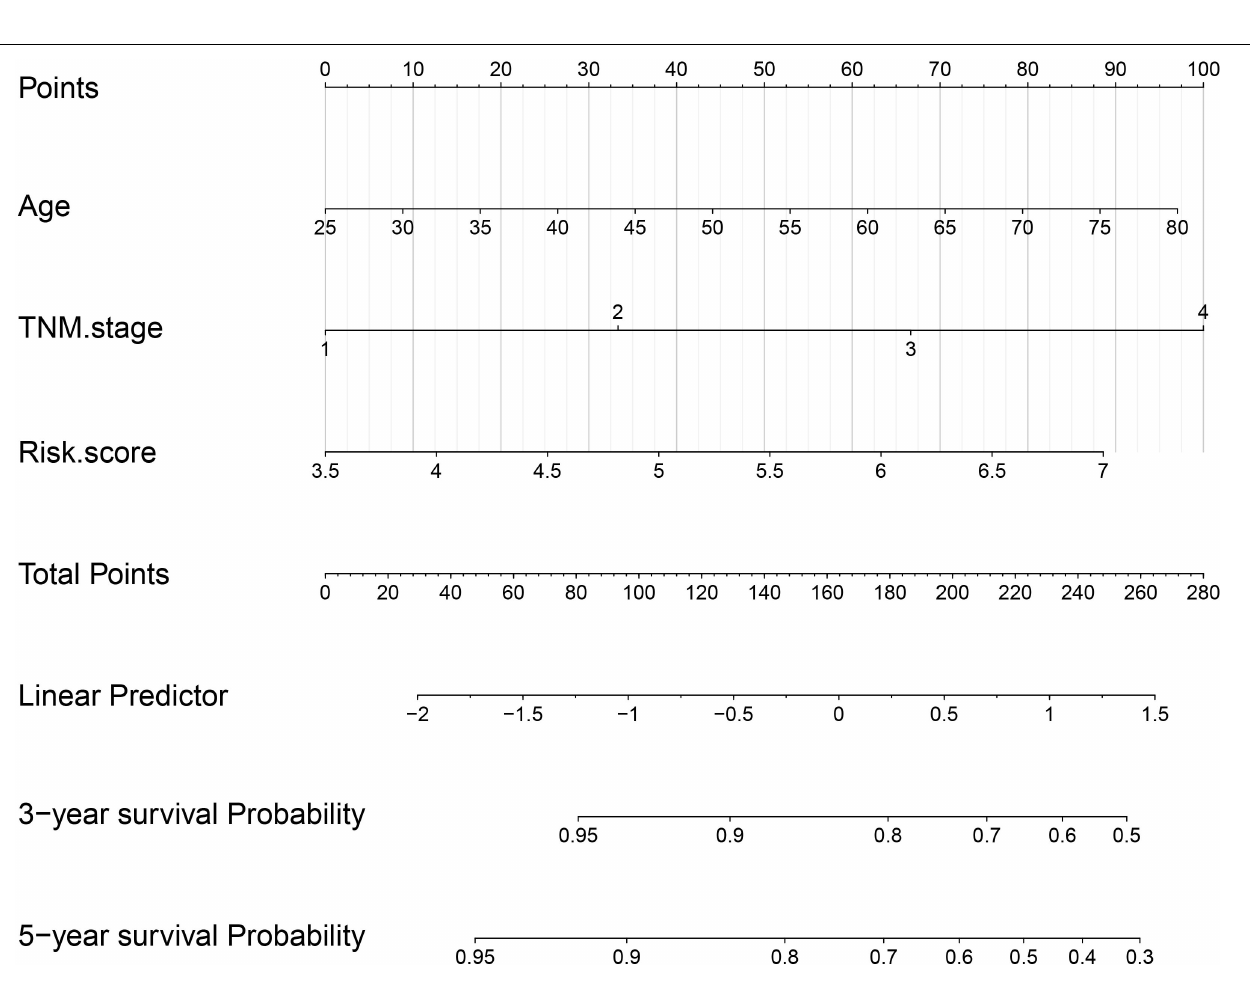
intersected genes ( TP53 , CFL1 , and UBA1 ) were singled out